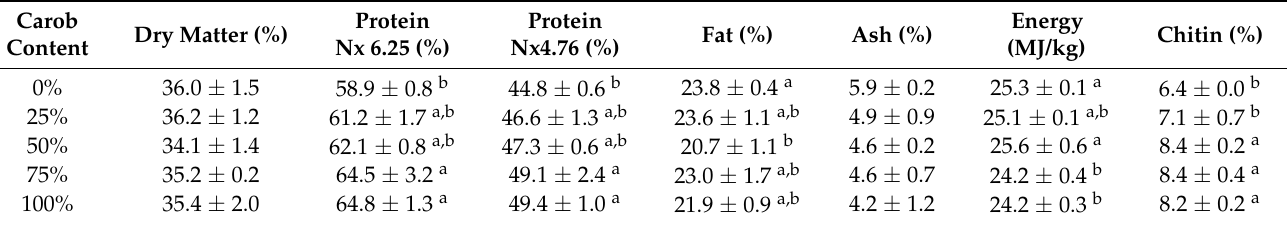
Table 2. Proximate composition of Tenebrio molitor larvae fed a control wheat bran substrate (0%) or substrates incorporating 25, 50, 75 or 100% carob